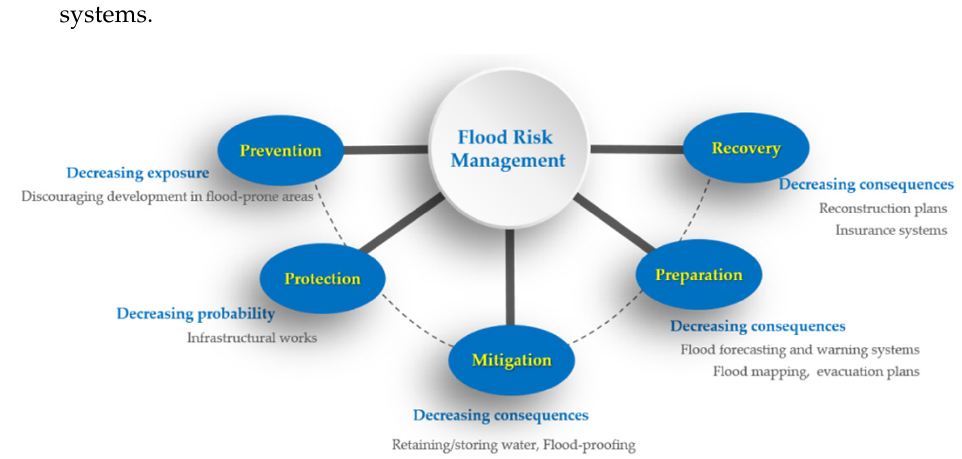
Figure 5. Modes of flood ‐ risk